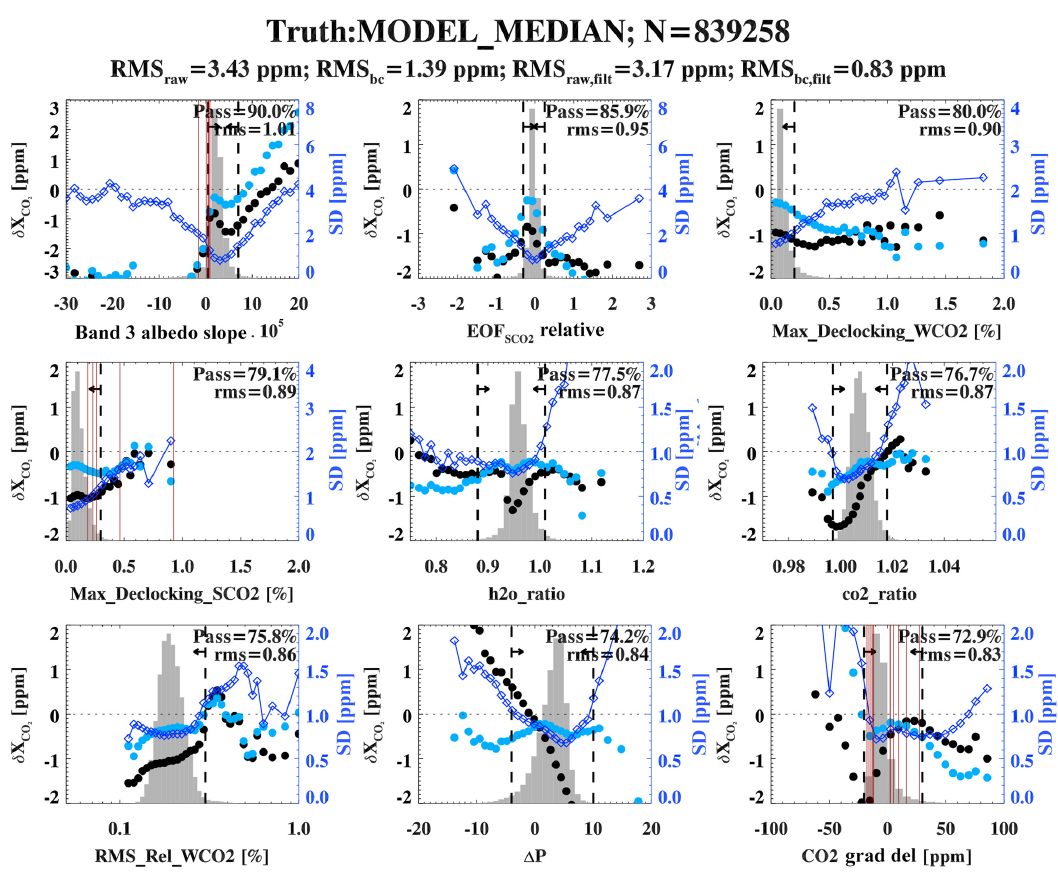
Figure 11. Same as Fig. 10 but for ocean glint measurements, where the truth proxy is the multi-model median.